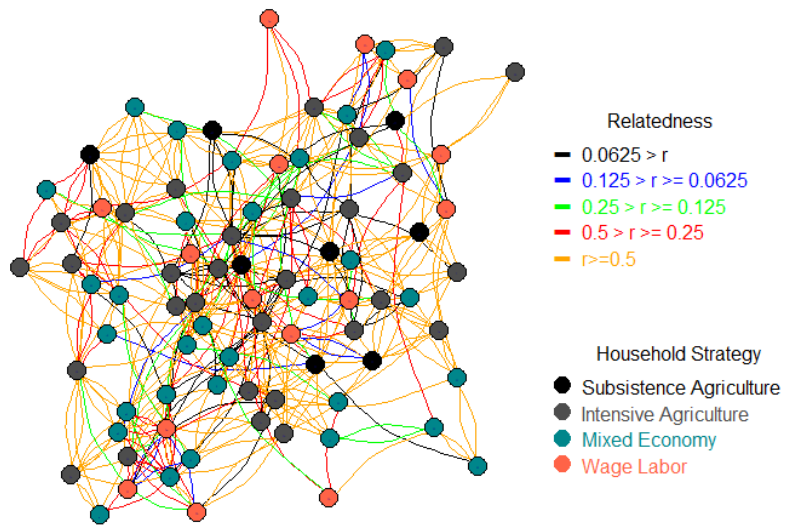
Figure 1. Household support networks showing the relatedness coefficient between households (lines), and household economic strategy (nodes).